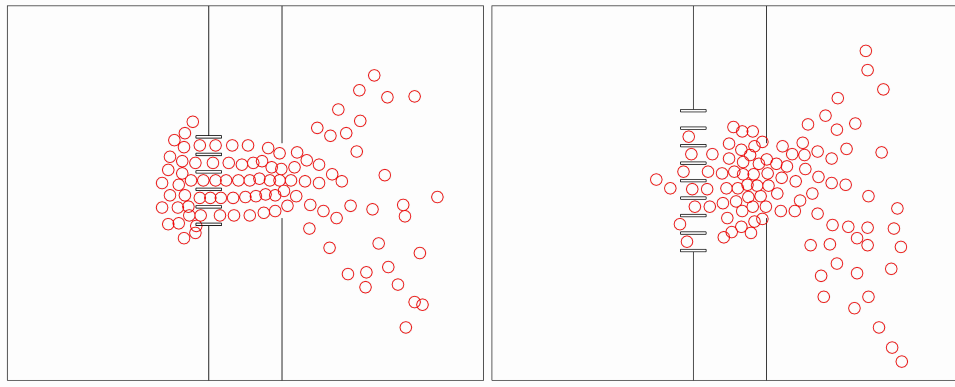
Figure 9. Snapshots of the evacuation process when the exit width is 3 m. ( Left ): The passage number is 5. ( Right ): The passage number is